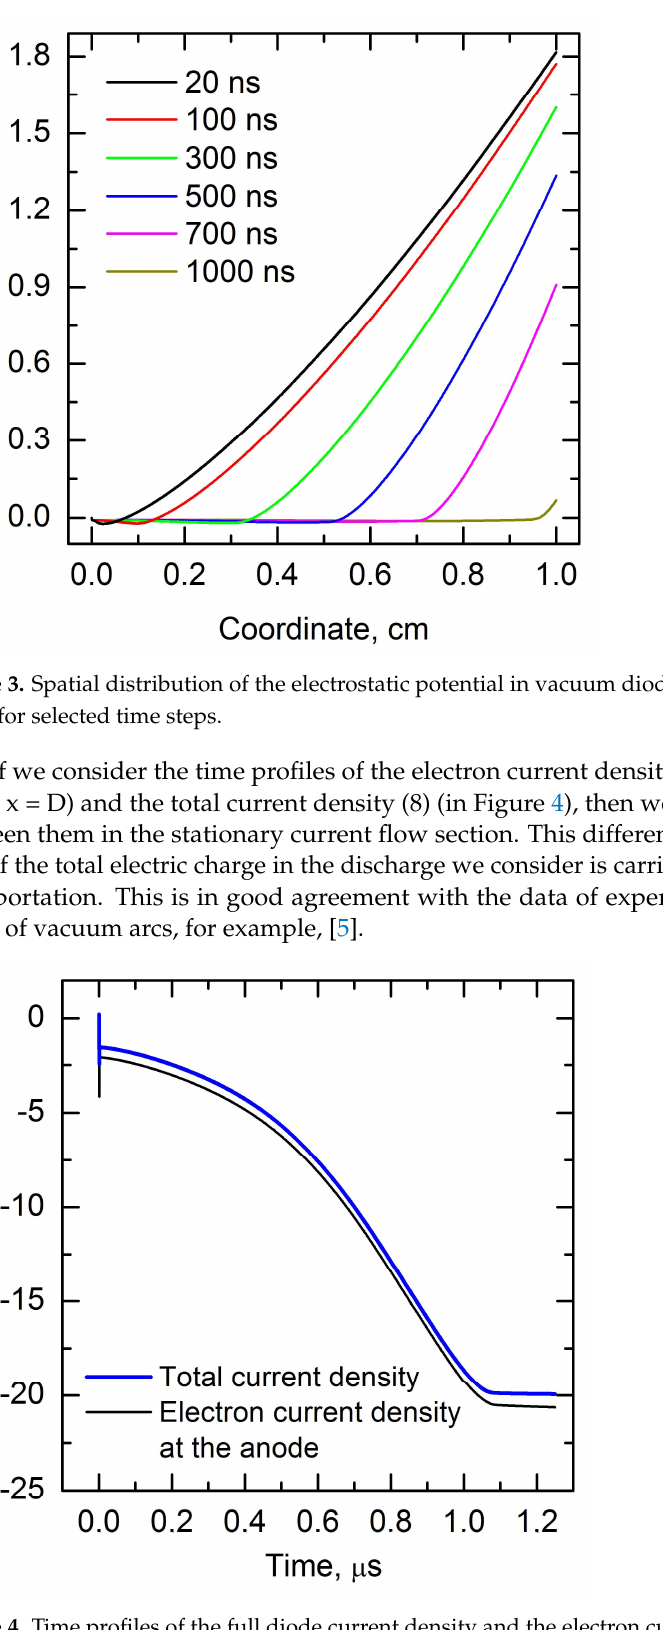
Figure 4. Time profiles of the full diode current density and the electron current density through the collector